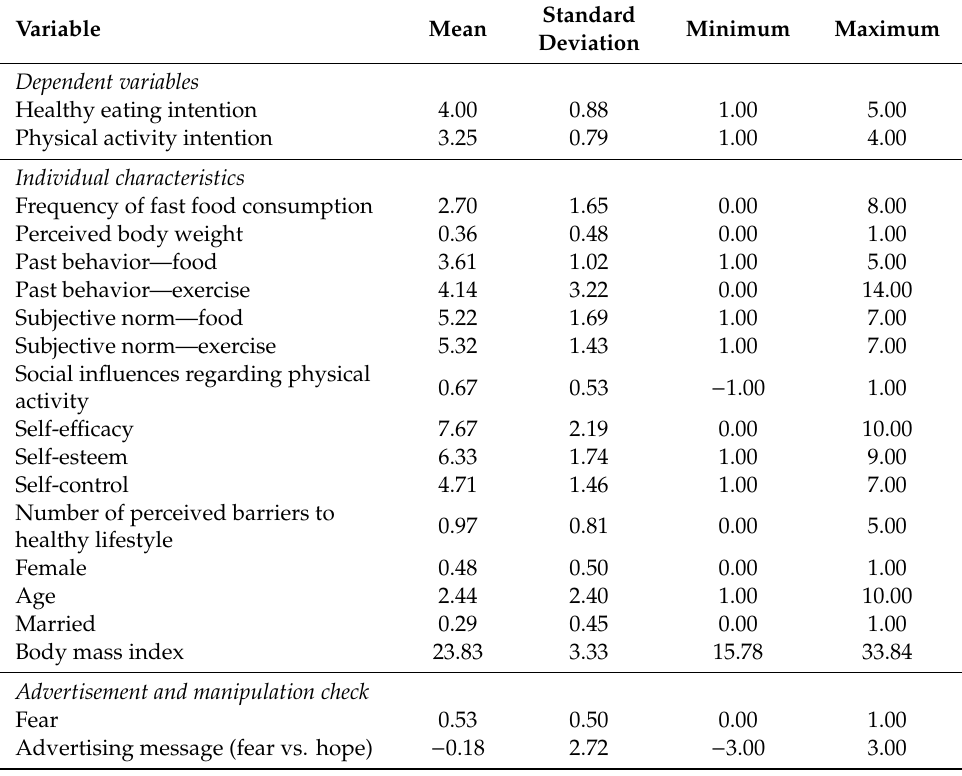
Table 2. Descriptive statistics.